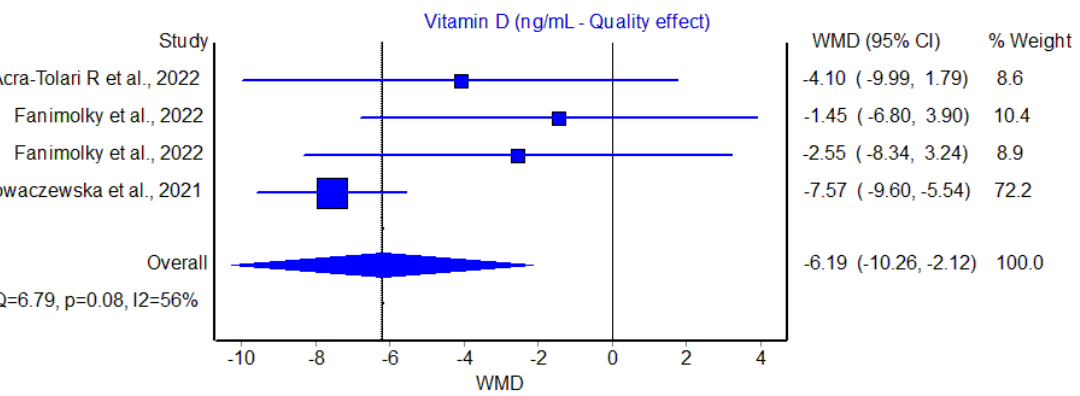
Figure 1. Weighted mean difference (WMD) and 95% confidence interval (95% CI) of serum vitamin D (Vit D) values in patients with or without tinnitus [16–18].